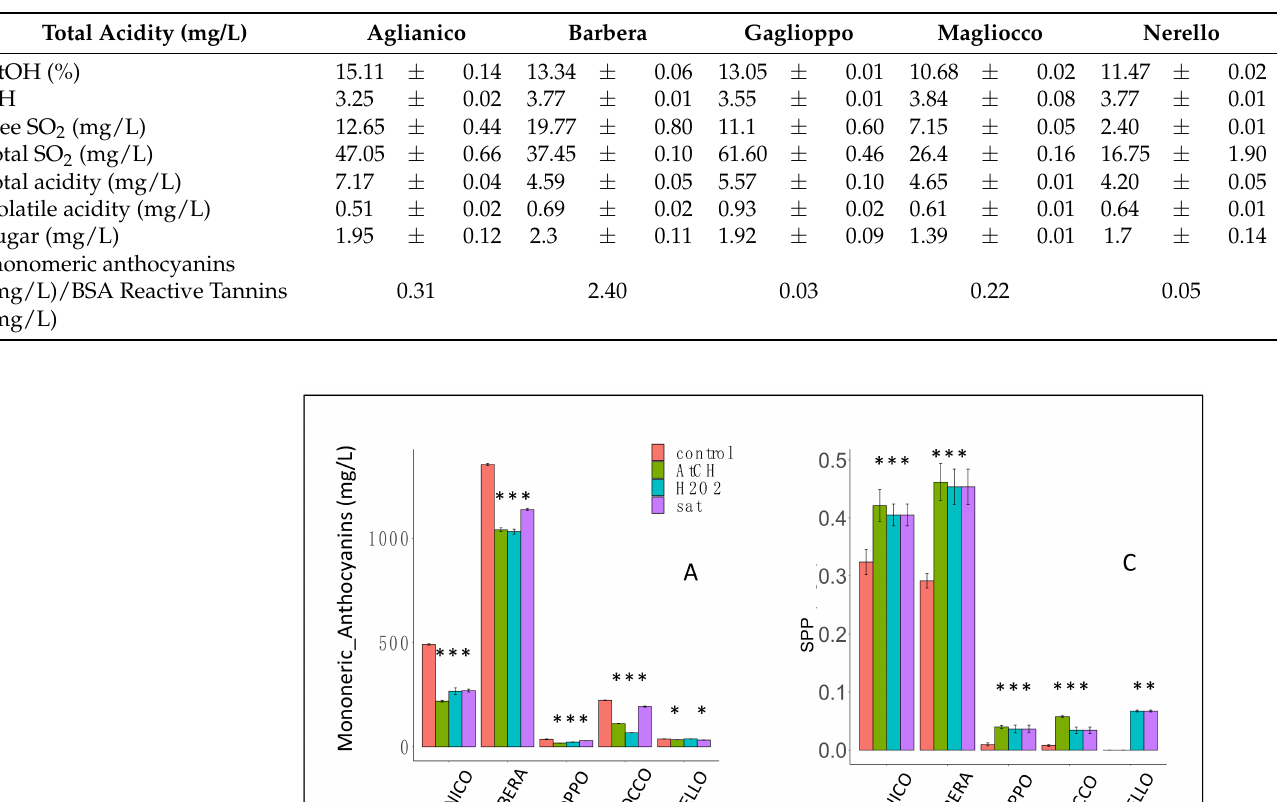
Table 1. Base parameters of Aglianico, Barbera, Gaglioppo, and Nerello wines before the treatments.